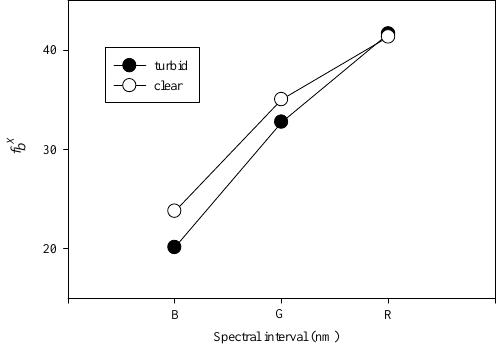
Figure 6. Proportion of bottom-derived radiance for different spectral region. Turbid and clear waters are defined based on contrasting cases shown in Figure 5.